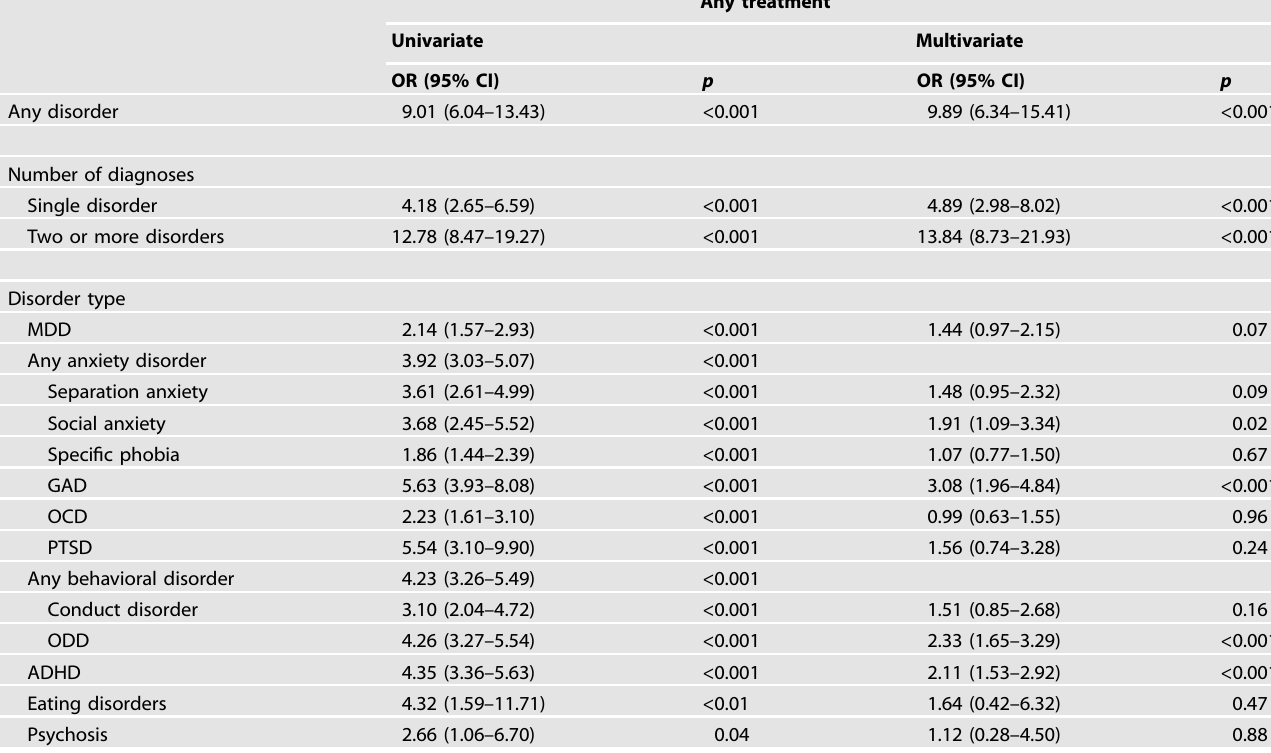
Table 5. Diagnostic predictors of psychiatric treatment utilization among children with lifetime history of pure suicidal ideation (unweighted n =